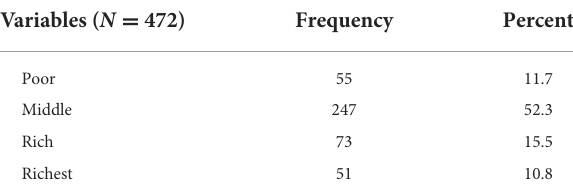
TABLE 1 Socio-demographic characteristics of pregnant women attending ANC service in East Shoa zone, Ethiopia, from June to August 2021.